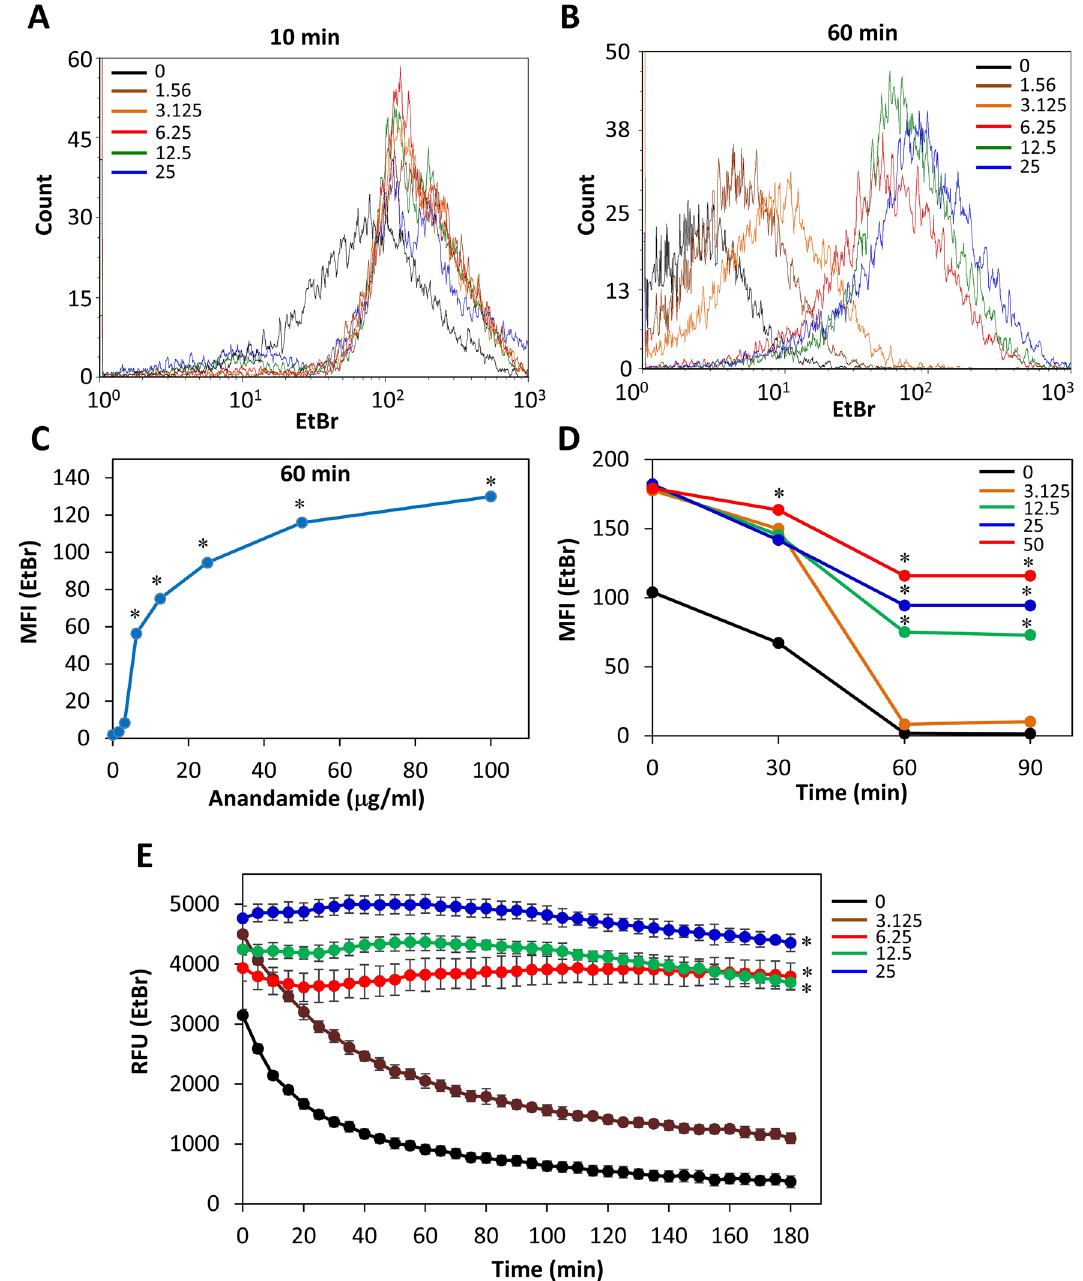
Figure 10. AEA prevents the efflux of ethidium bromide (EtBr) from MDRSA CI-M. ( A , B ) Flow cytometry of EtBr retained in MDRSA CI-M 10 min ( A ) and 60 min ( B ) after treating the bacteria with different concentrations of AEA. ( C ) The summary of the geometric mean fluorescence intensity (MFI) of samples shown in ( B ). ( D ) The MFI of the various treatments in a time course study using flow cytometry. ( E ) A time